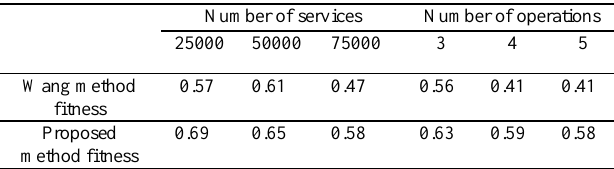
Table 3. Fitness of Wang Method and Proposed Method.